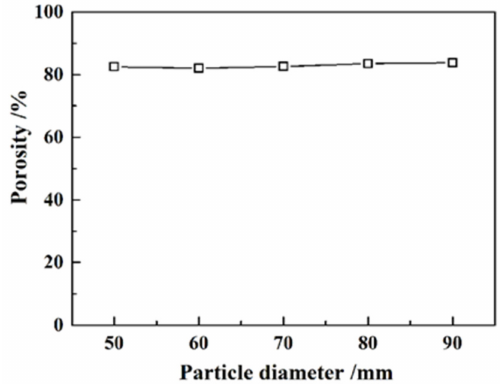
Figure 4. Simulation results of rigid-sphere stacking.